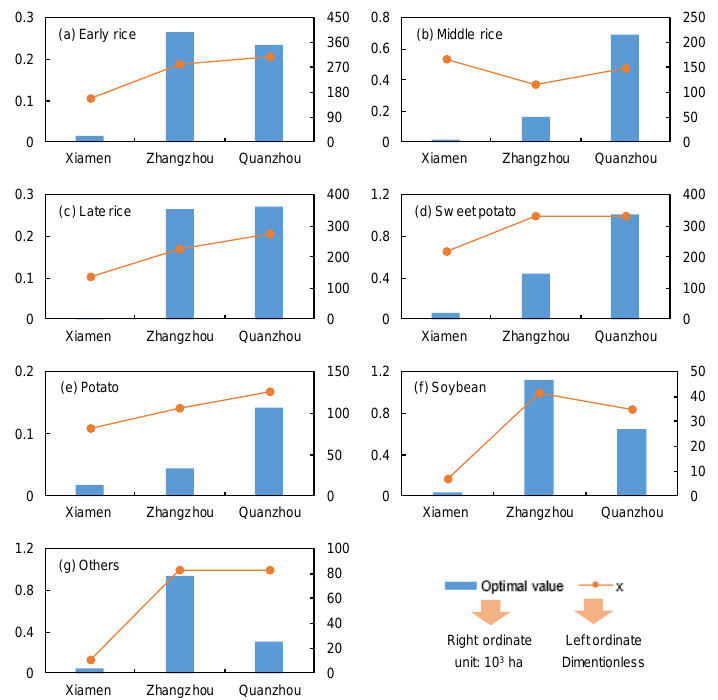
Figure 4. Optimal cropland area target: ( a ) Early rice, ( b ) Middle rice, ( c ) Late rice, ( d ) Sweet